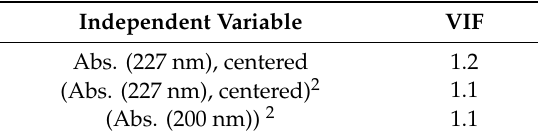
Figure 4. QQ-plot for the obtained model: soluble AOX. Table 4. VIFs for the obtained model: soluble